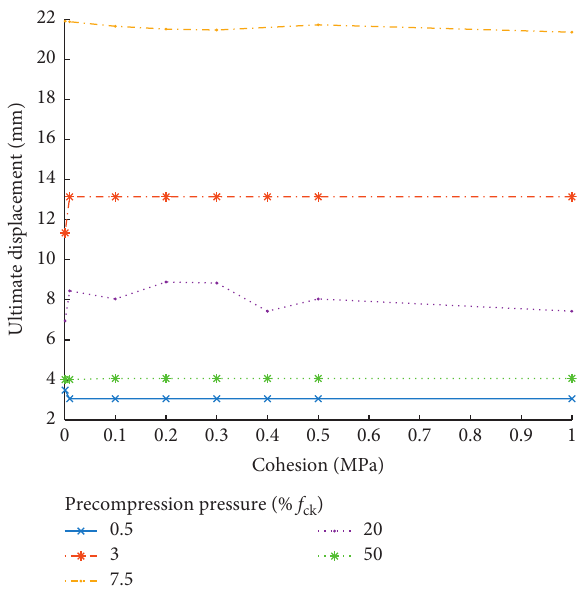
Figure 20: Ultimate displacement vs cohesion for varying precompression Table 3: Coefficient estimates for regression with standard error.